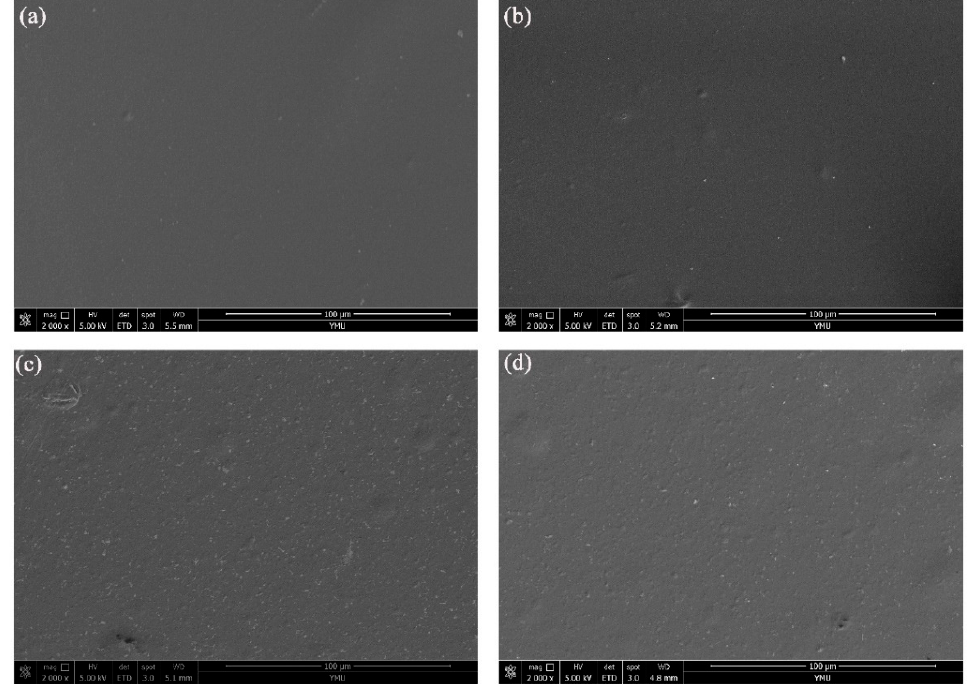
Figure 2. SEM micrographs of the surface of the bio-nanocomposite film: ( a ) SA film, ( b ) SA/CIN film, ( c ) SA/T-HNTs film, and ( d ) SA/T-HNTs-CIN